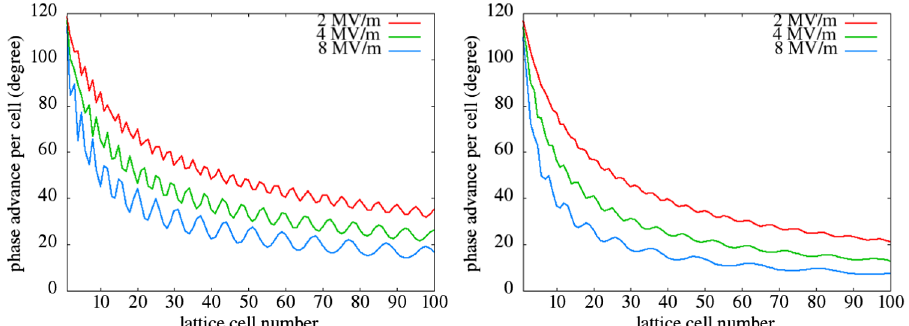
FIG. 6. The zero current horizontal (left) and longitudinal (right) phase advances as a function of lattice cell number in the solenoid-rf channel.